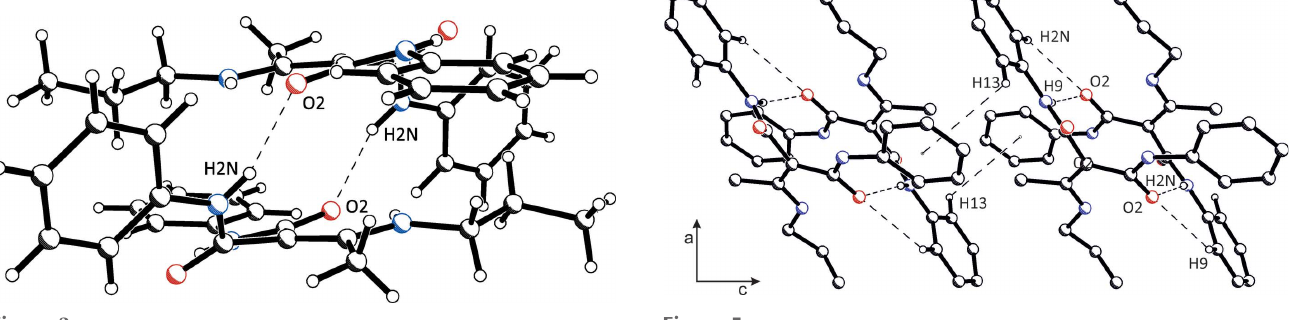
Figure 3 Intermolecular N—H (cid:2)(cid:2)(cid:2) O interactions leading to dimers in the crystal structure of ( I ), representative of both polymorphs. Herbig and Bo ¨ hme (cid:5) two polymorphs of C 20 H 23 N 3 O 2